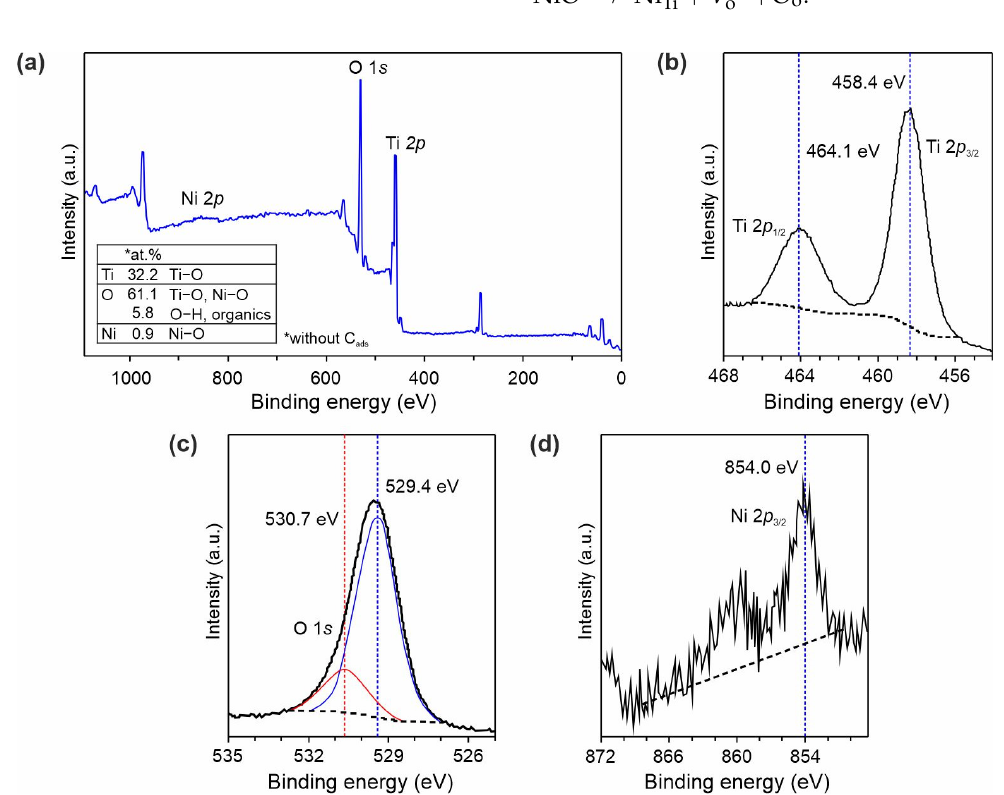
Figure 4. ( a ) XPS survey scan and high-resolution spectra of ( b ) Ti 2 p , ( c ) O 1 s , and ( d ) Ni 2 p core levels for TO-Ni-05